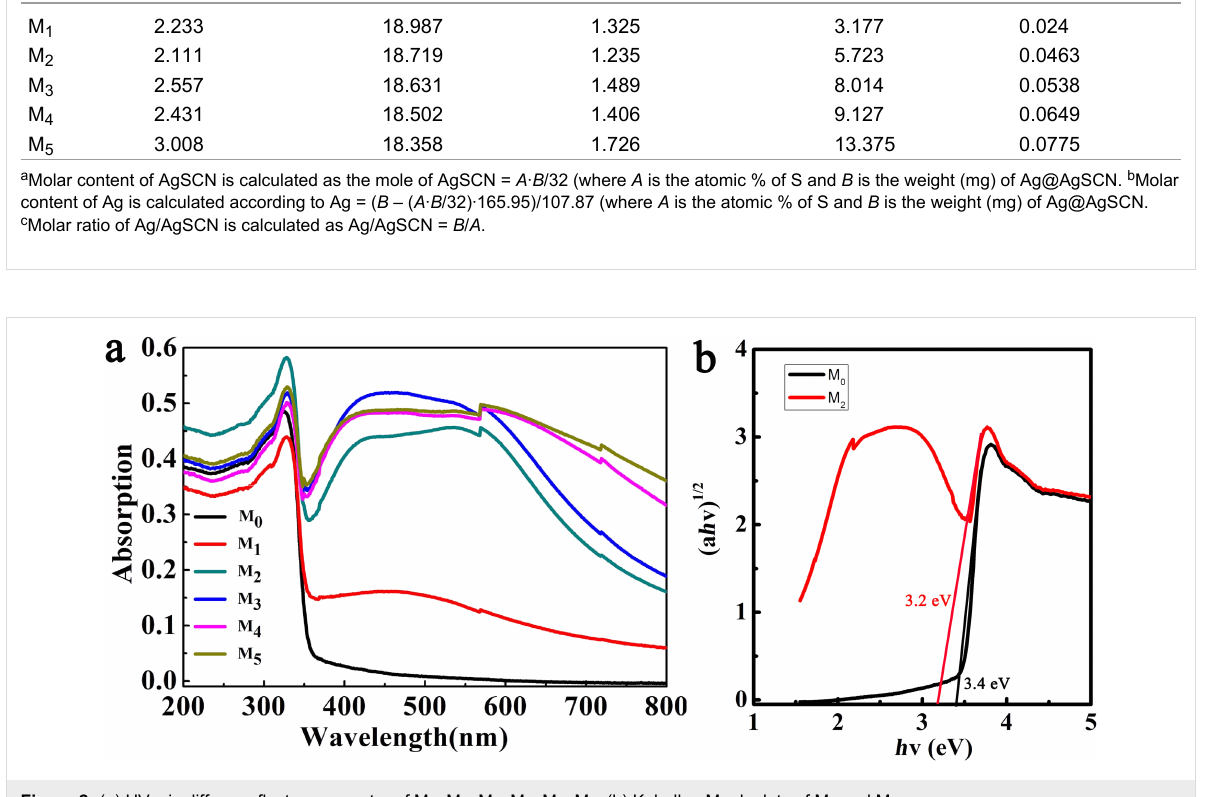
Figure 2: (a) UV–vis diffuse reflectance spectra of M 0 , M 1 , M 2 , M 3 , M 4 , M 5 . (b) Kubelka–Munk plots of M 0 and M 2